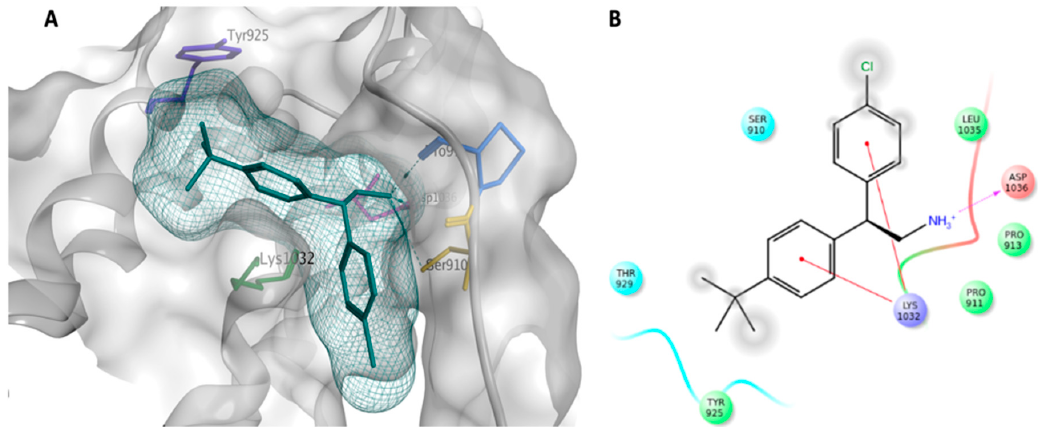
Figure 3. ( A ) The predicted binding mode of compound I (cyan sticks) inside the pocket of the FAK- FAT domain (grey) pocket, showing interaction with Asp 1036 (pink), Ser 910 (yellow), Pro 911 (blue), Lys 1032 (green), and Tyr 925 (purple); hydrogen bonds are indicated by the cyan dashed lines. ( B ) The detailed interactions between compound I and the FAK-FAT domain. ( B ) The detailed interactions between compound I and the FAK-FAT